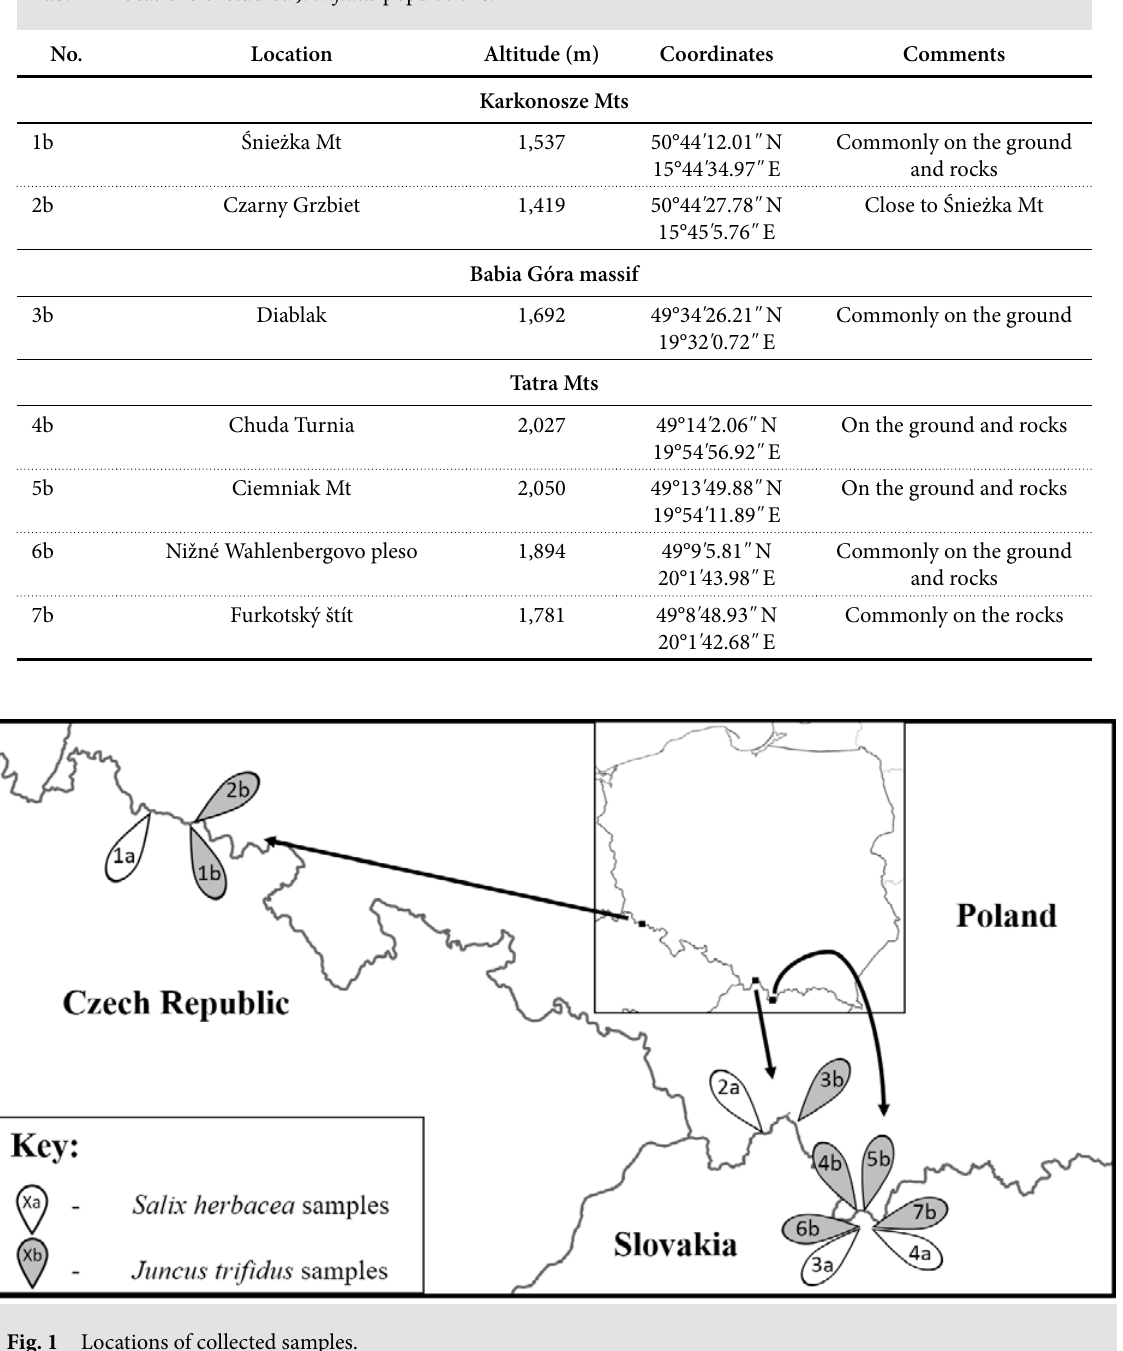
Fig. 1 Locations of collected